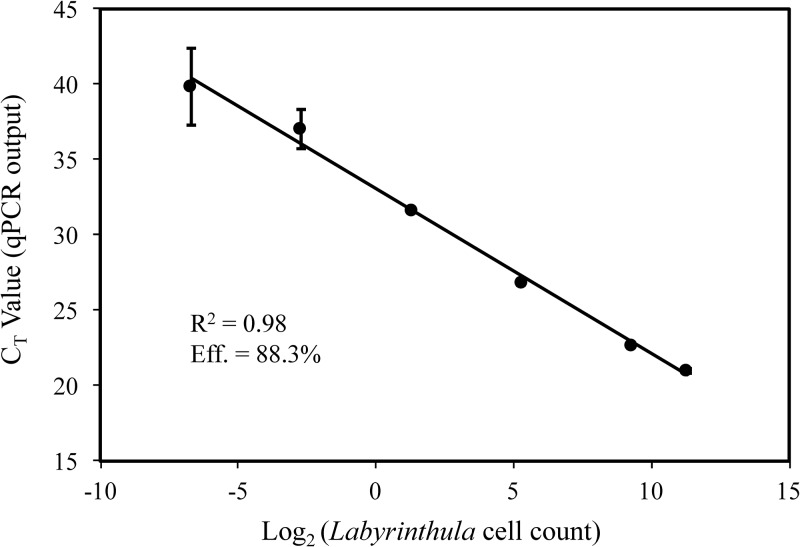
qPCR extraction efficiency.The number of Labyrinthula sp. “E” isolate 8b cells μL-1 (log2) across a cell dilution series is plotted against threshold (CT) values to calculate extraction efficiency. Each sample was run in triplicate. Error bars represent ±1 SEM.